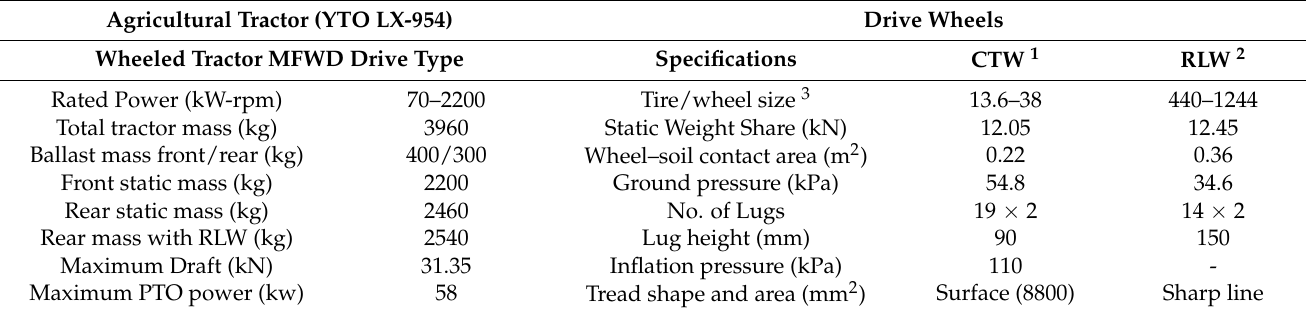
Table 3. Specifications of tractor and drive